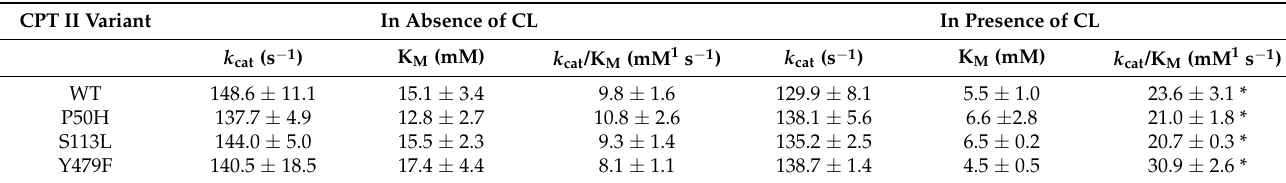
Table 2. Effect of 0.25 mM CL on the kinetic parameters k cat and K M and the catalytic efficiency of CPT II WT and variants for L-carnitine as varying substrate at 25 ◦ C ( n ≥